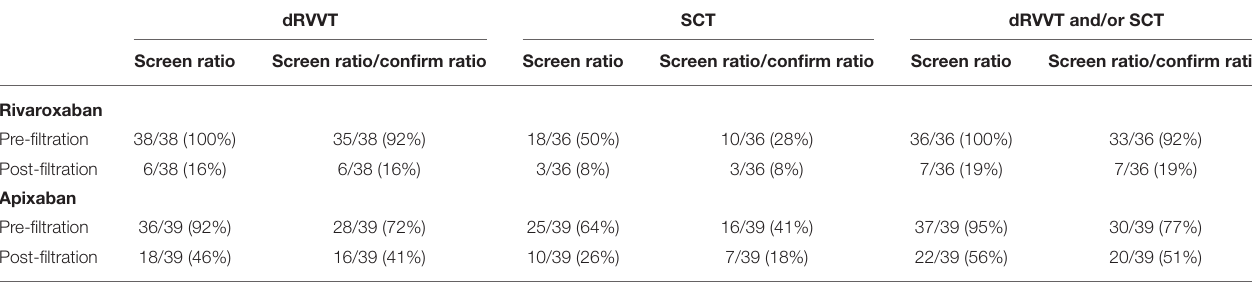
TABLE 2 | Percentage of positive LA results in pre- and post-filtration patients’ samples. dRVVT SCT dRVVT and/or SCT Screen ratio Screen ratio/confirm ratio Screen ratio Screen ratio/confirm ratio Screen ratio Screen ratio/confirm ratio